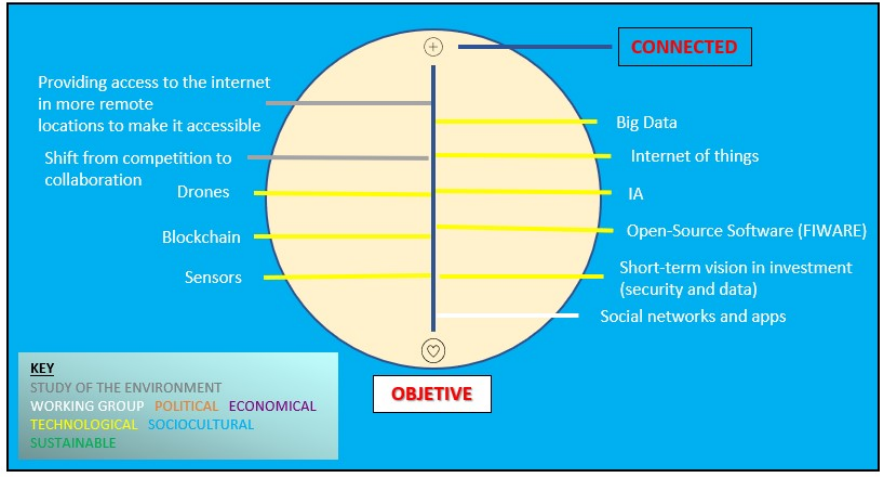
Figure 20. Elements of connected ports. Source: own elaboration. In order to be more innovative, ports will need as differentiating element indicators from the working group block, including new employer profiles and job opportunities, new work methodologies and social networks and apps.